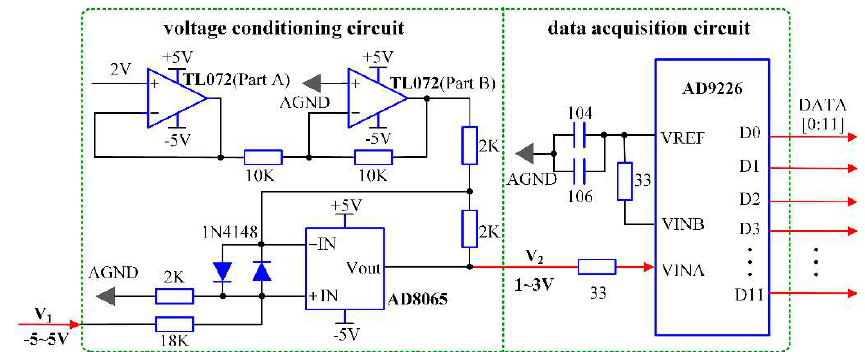
Figure 2. A/D sampling module.